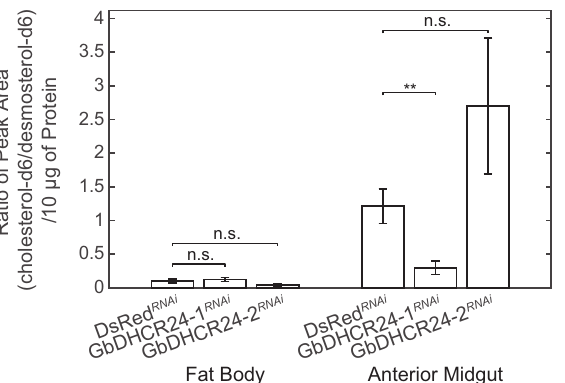
Figure 6. Enzyme activity of the 15,300 × g -pellet fraction extracted from fat body and anterior midgut of GbDHCR24 knockdown crickets ( n = 6). The changes in enzyme activity between the DsRed RNAi and GbDHCR24 RNAi crickets were analysed by the Mann–Whitney U test. The significance is indicated by ** p < 0.01. n.s. indicates no significance between groups. Data are presented as mean ±